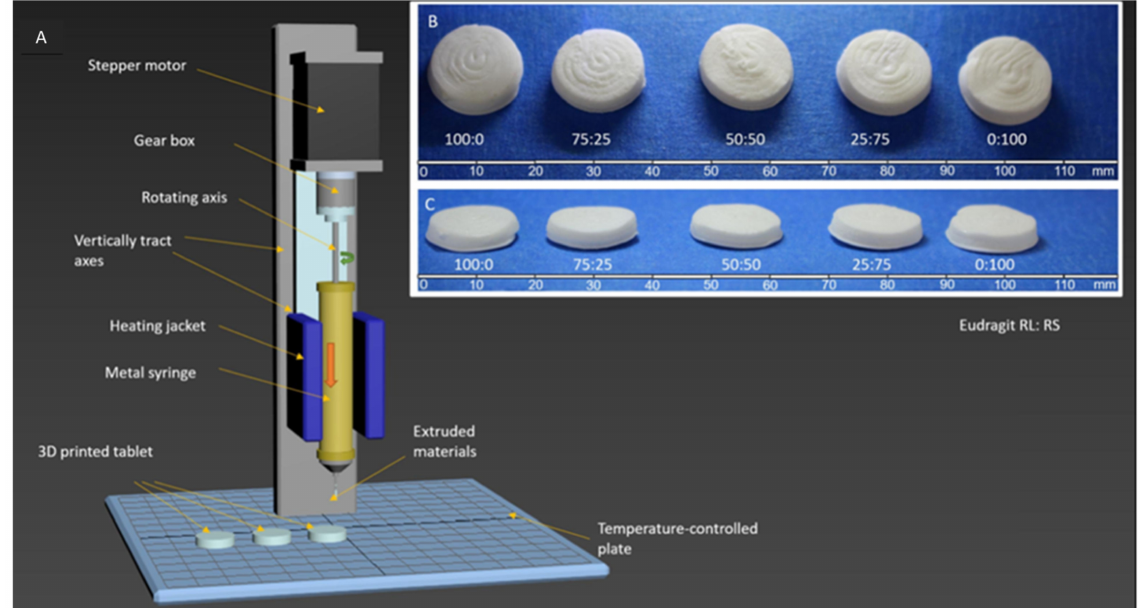
Figure 7. ( A ) Set-up for direct extrusion 3D printing. The printer is equipped with a metal syringe surrounded by a temperature-controlled heating jacket. The syringe is fitted with a luer-lock stainless steel needle (G18), and the pharmaceuti- cal ink (compressed powder) is added. The ink is then extruded by a piston pushed by a computer-controlled stepper motor equipped with gear to produce 3D-printed tablet. ( B ) Top and ( C ) side photographs of 3D-printed tablets based on Eudragit